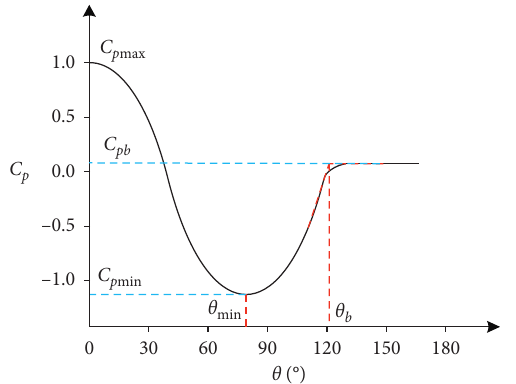
Figure 6: Definition of the characteristic parameters.